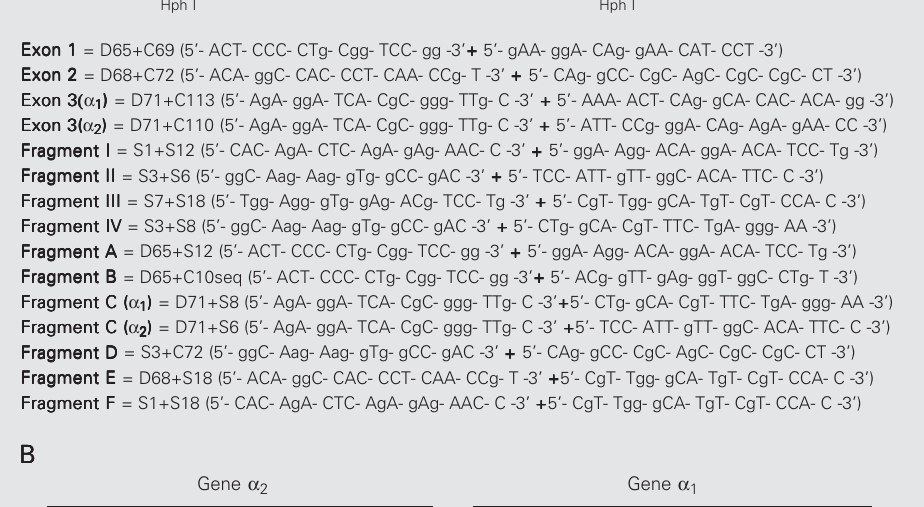
DFragment DFragment